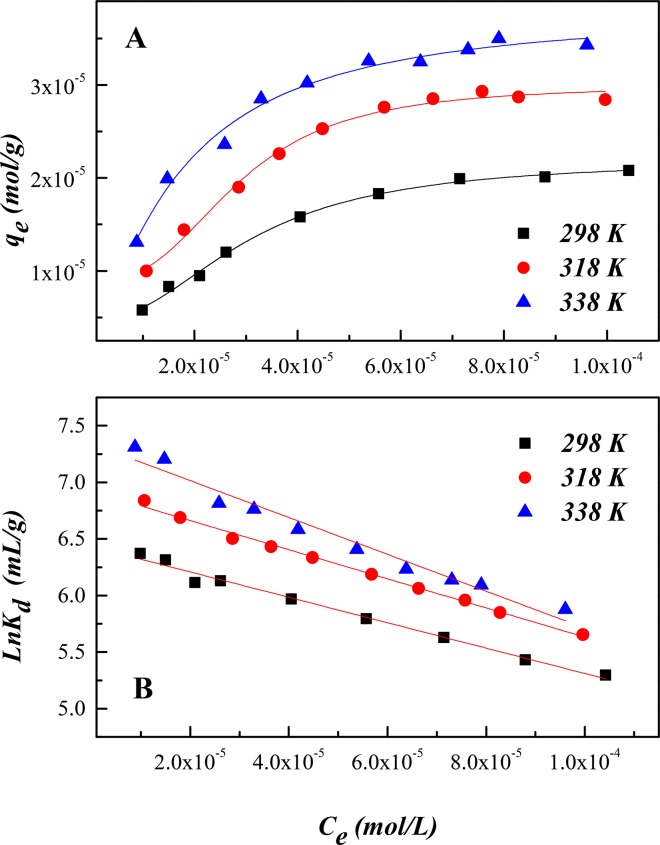
The thermodynamics of U(VI) sorption on SONPs (I = 0.01 mol/L NaClO4, s/l = 0.6 g/L, pH = 5.0±0.1).(A) Sorption isotherms at three different temperatures. (B) Linear plots of lnKd versus Ce.